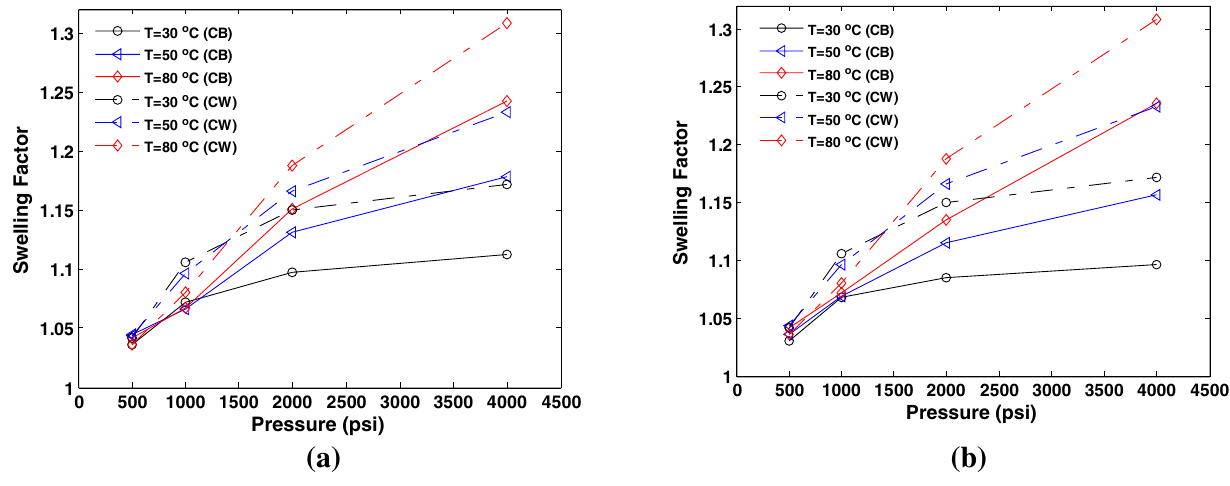
Fig. 7 Comparison of swelling factor in the presence and absence of a Na